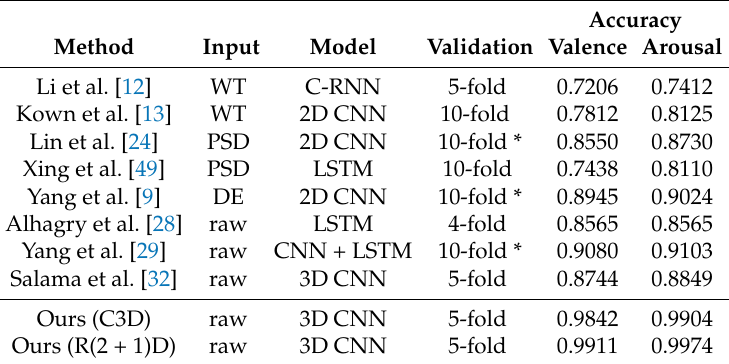
Table 2. Average accuracies of binary classification using different approaches on the DEAP dataset. (* in validation denotes subject-wise